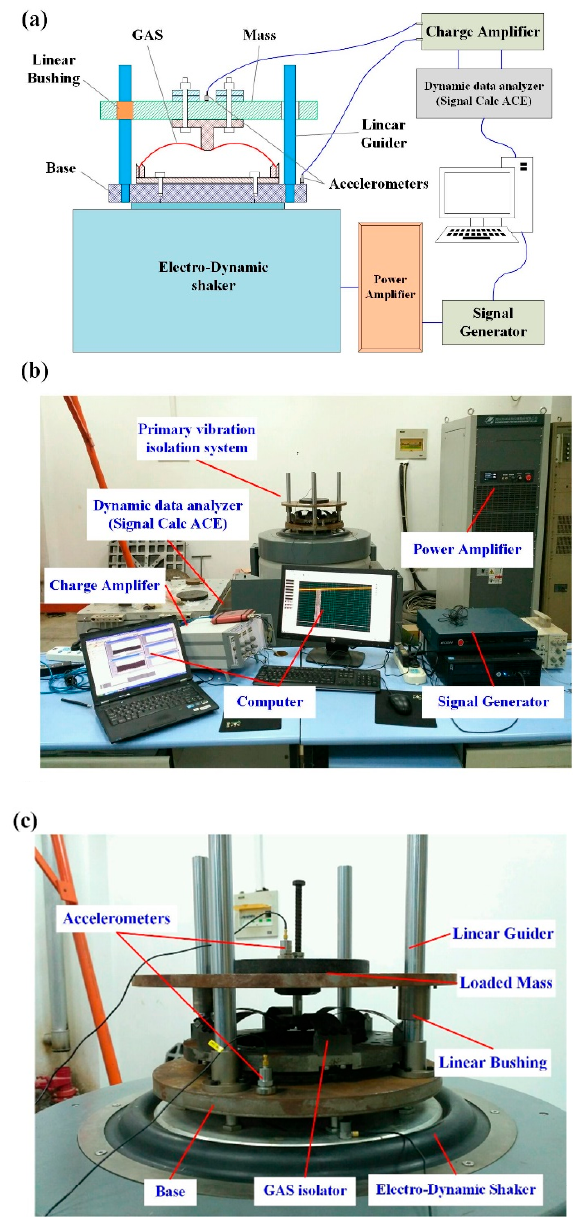
Figure 8. Dynamic experimental system for the geometric anti-spring isolator. ( a ) Schematic of the dynamic experimental setup; ( b ) Photograph of the dynamic experimental setup; ( c ) Photograph of the primary vibration isolation system.